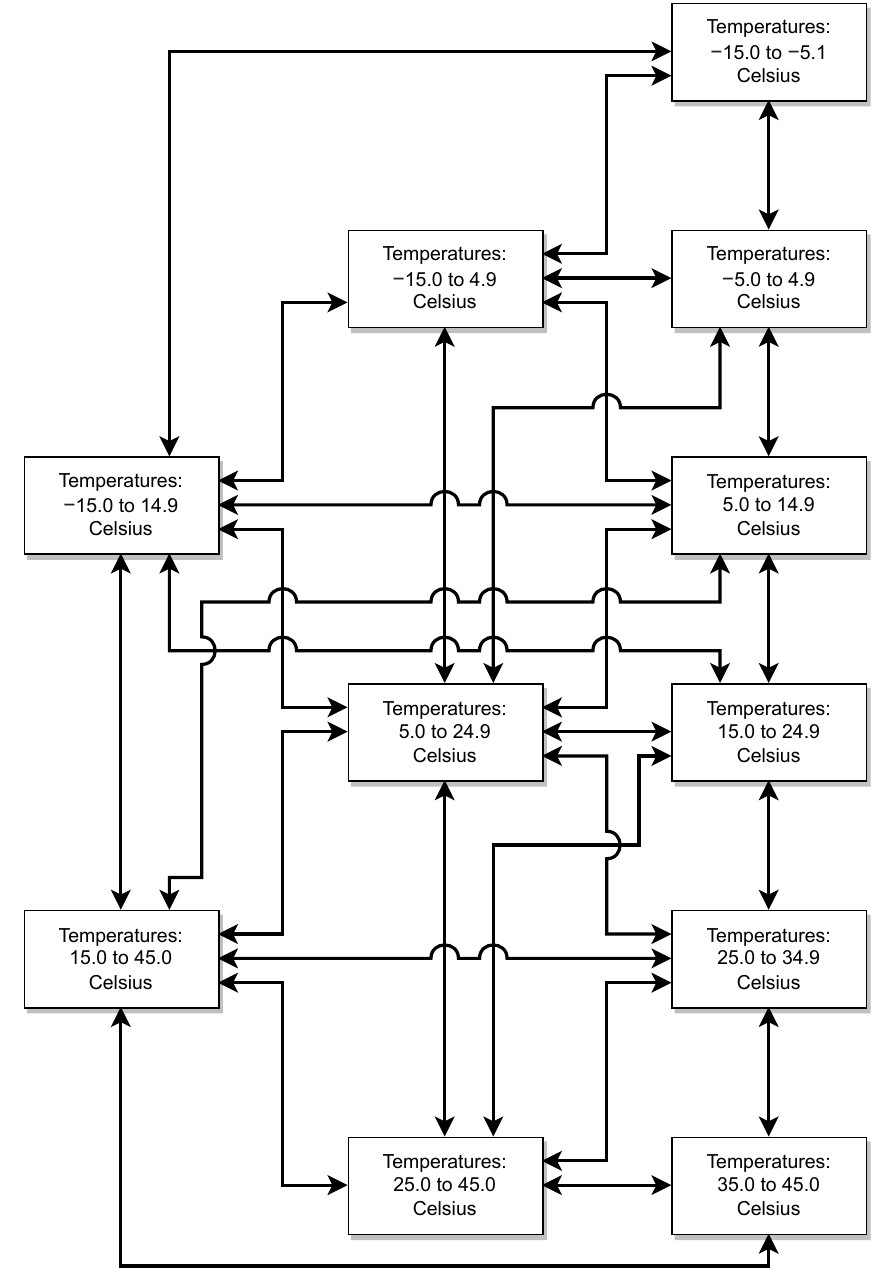
Figure 5. Temperature graph: To construct a d -day MIM, we chose data from different tempera- ture groups for each day. The temperature group for the first day was chosen randomly, and the temperature groups for the following day were chosen according to the graph